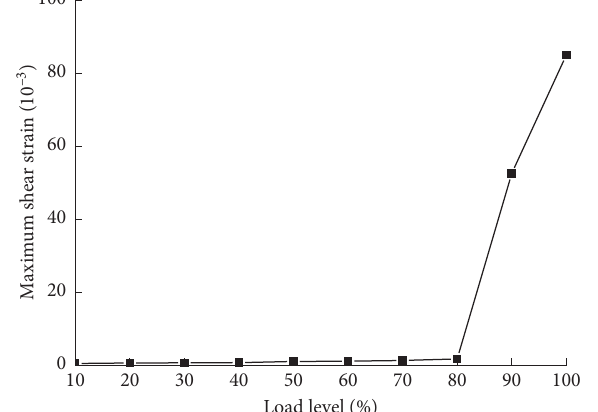
Figure 10: Evolution of maximum shear strain (B-30).